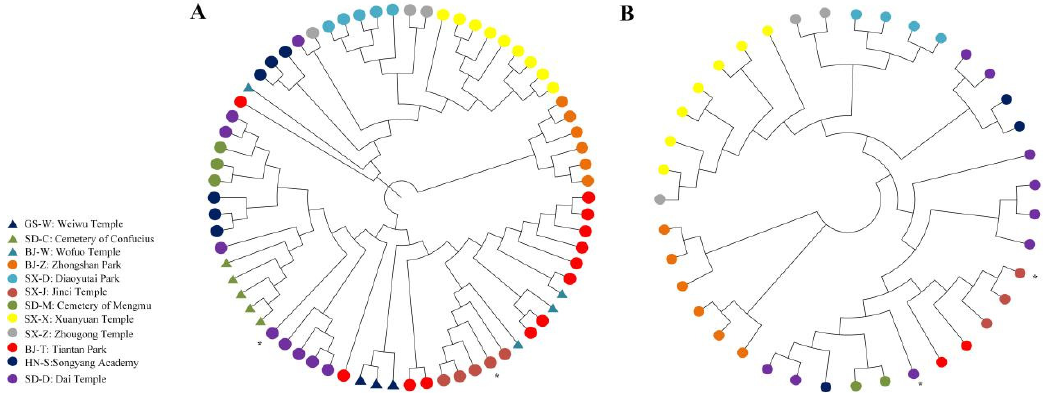
Figure 3. Phylogenetic tree constructed according to the neighbor-joining method with polymorphic SNPs. ( A ): Phylogenetic tree based on P. orientalis trees over 500 years old; ( B ): Phylogenetic tree based on P. orientalis trees over 1000 years old.